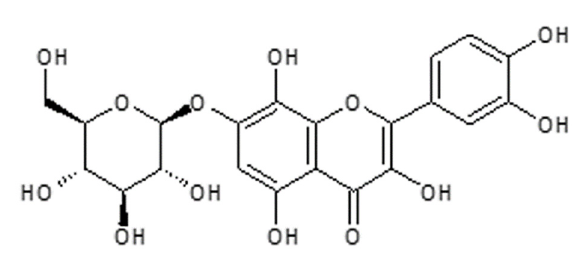
Figure 1. Gossypitrin (Gos) structure. 2-(3,4-Dihydroxyphenyl)-3,5,8-trihydroxy-4-oxo-4H-chromen-7-yl β - D -glucopyranoside.